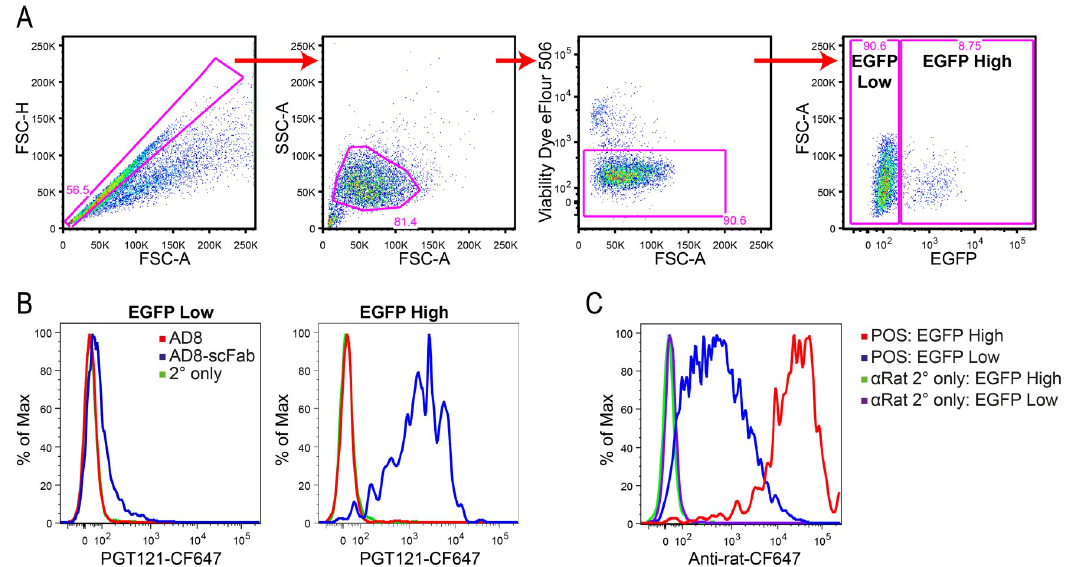
Fig 4. Binding of Clec9A-targeting constructs to cell surface Clec9A. (A) 293T cells were transfected with pClec9A-EGFP. Cells were incubated with Env constructs, and then fluorescently stained with PGT121-CF647. For a positive control of Clec9A expression, cells were stained with 10B4, followed by anti-rat-IgG2a-CF647. Cells were initially gated for single cells followed by selection of eFluor-506 negative cells to remove dead cells. Cells were then gated as being either EGFP High or EGFP Low. (B and C) Histogram showing CF647 fluorescence, indicative of Clec9A binding, on EGFP High and Low cells incubated with Env constructs (B) or Positive control 10B4 antibody (C). Cells were gated as described in A and curves were normalized to mode. Data shown are representative of 3